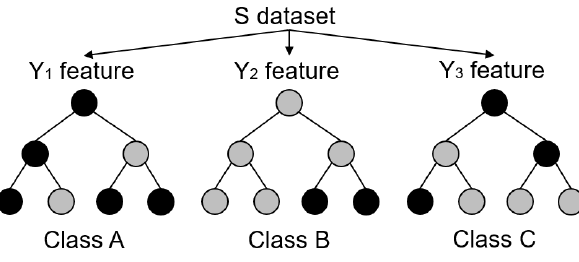
Figure 1. Simplified structure of a RF [25].